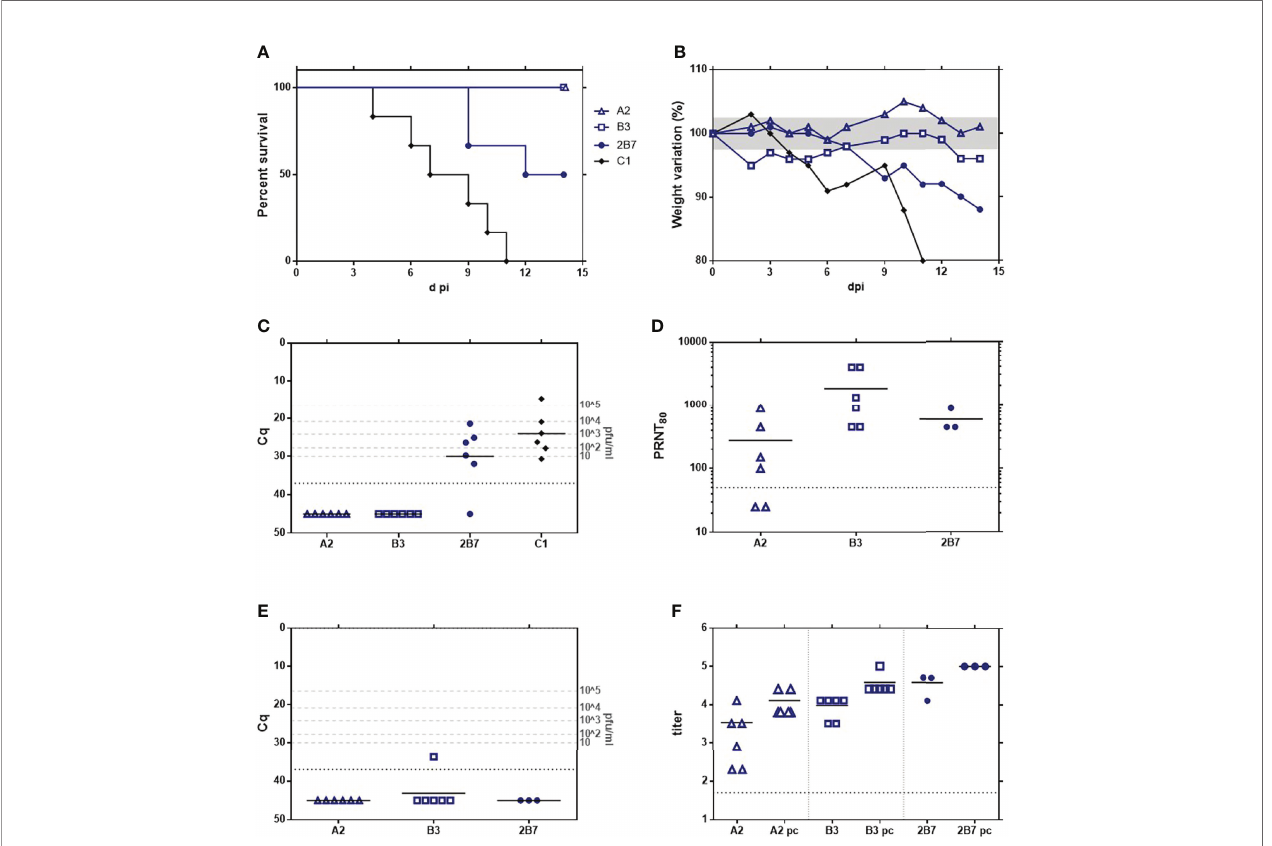
FIGURE 5 | Analysis of the immunogenicity and vaccine ef fi cacy of the rZH548-L mutant viruses in 129 (wt) mice. Groups of 4-month-old mice (n = 6, including male and female equally distributed) were inoculated with 500 pfu of rA2 and rB3 viruses. C1 (rZH548) and 2B7 (rZH548-P82L) were included for a comparison. 3 weeks later survivors were challenged with a lethal dose of 1000 pfu of C1 (rZH548). (A) Survival rates after fi rst inoculation. (B) Percentage weight variation, geometric mean per group. The area between 97.5 and 102.5% has been shaded. (C) Viremia determined by RT-qPCR on EDTA blood samples collected at day 3 pi. Samples giving a Cq (quanti fi cation cycle) value under the detection level of the assay (37) are arbitrarily represented as 45. The correlation of Cq data with pfu equivalents (Moreno et al., 2020) is indicated in the right Y axis. (D) Neutralizing antibodies at day 12 pi as determined by a plaque reduction assay. (E) Viremia determined by RT-qPCR on EDTA blood samples collected at day 3after challenge. (F) Antibodies to N protein by ELISA both pre- and post-challenge (small and large symbols